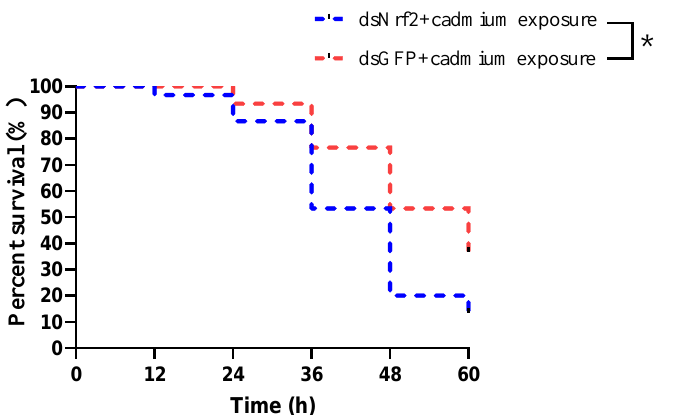
Figure 6. The percentage survival of mud crabs in the dsNrF2 group and dsGFP group (the dsGFP group was used as the control) after cadmium exposure. Asterisks reflected significant differences between the dsNrf2 group and the dsGFP group.